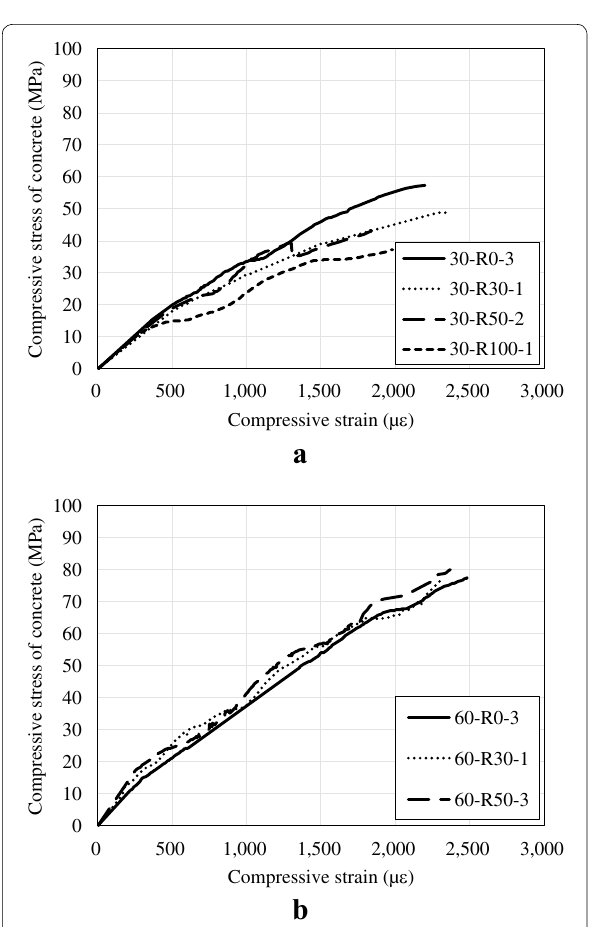
Fig. 3 Relationship between compressive stress and strain of specimens of NS concrete, and HS